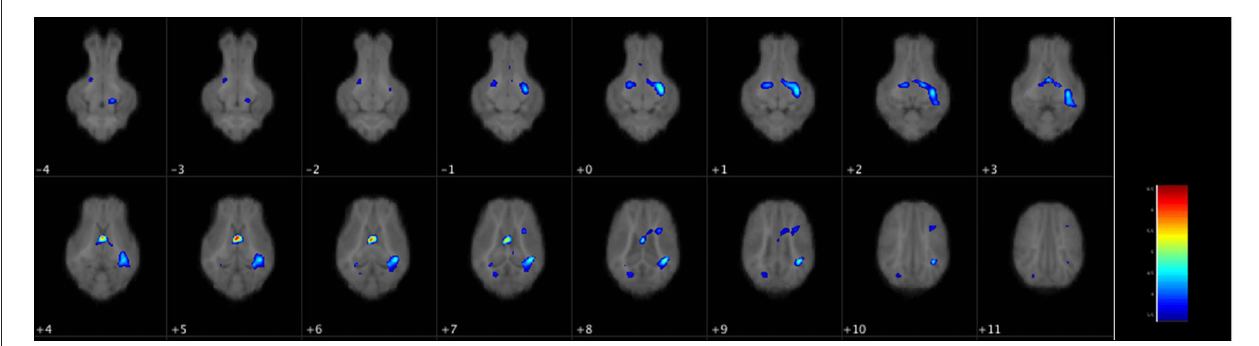
a Values are means of pigs with MRI data collected at 26–29 days of age. Relative volumes of regions of interest were obtained by determining their percent of whole brain volume for individual pigs prior to statistical analysis. AGA CON: n = 8; AGA HF: n = 8, n = 7 (lateral and fourth ventricle); SGA CON: n = 8, n = 7 (fourth ventricle), n = 6 (lateral ventricle); SGA HF: n = 9, n = 8 (gray matter, lateral ventricle, white matter). Bold values are significance. b Size, main effect of birth weight (i.e., AGA vs. SGA); Diet, main effect of dietary intervention (i.e., HF vs. CON); Size * Diet, interaction effect of birth weight, and dietary intervention.